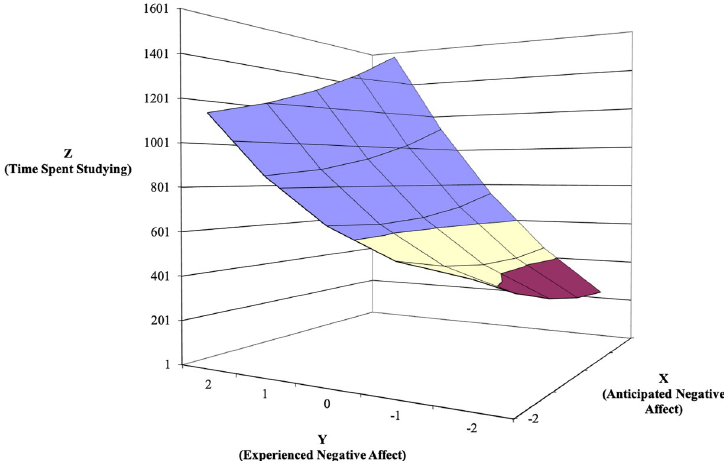
Fig 7. Response surface area wherein time spent studying is predicted by anticipated—experienced negative affect discrepancy (Study 2).